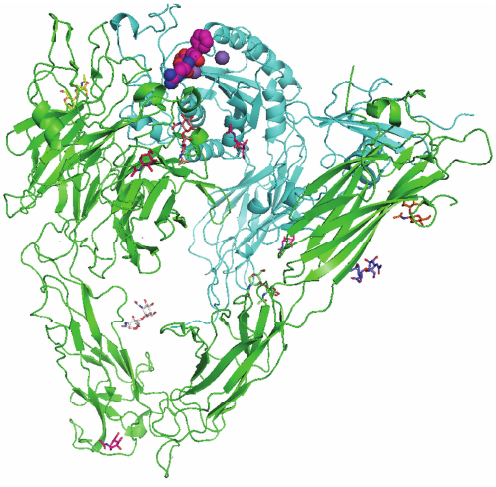
Figure 1: View of α v β 3 integrin from 1L5G.pdb (Xiong et al., 2001 [4]). RGD cyclic pentapeptide is shown as space filling atoms (violet), NAG sugars are stick figures in various colors, and the sphere (purple) is a Mn 2+ ion. The α v domain is green and the β 3 domain is cyan. Figure drawn with